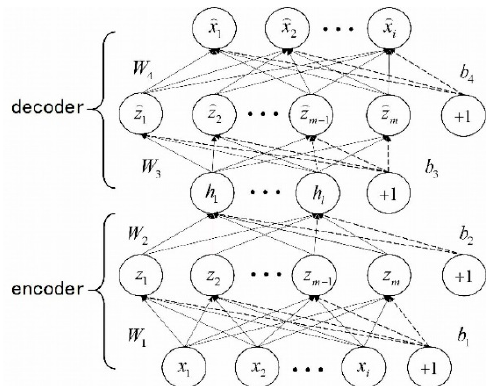
Figure 1. Structure of sparse stack autoencoder (SSAE).